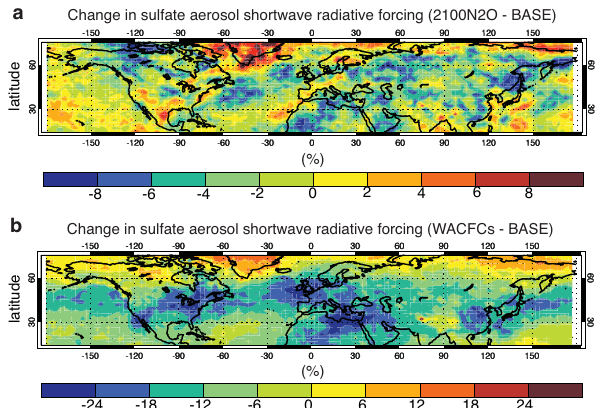
Fig. 4. Changes in sulfate radiative forcing. Annual mean difference of midlatitude sulfate aerosol radiative forcing (shortwave, top-of- the-atmosphere) in the 2100N2O (a) and the WACFCs (b) simula- tions, from the BASE run. Note that changes are statistically signif- icant only for isolated regions in the mid-north Atlantic, Mediter- ranean and northern East Asia in (a) , but for almost all mid-latitude regions in (b)